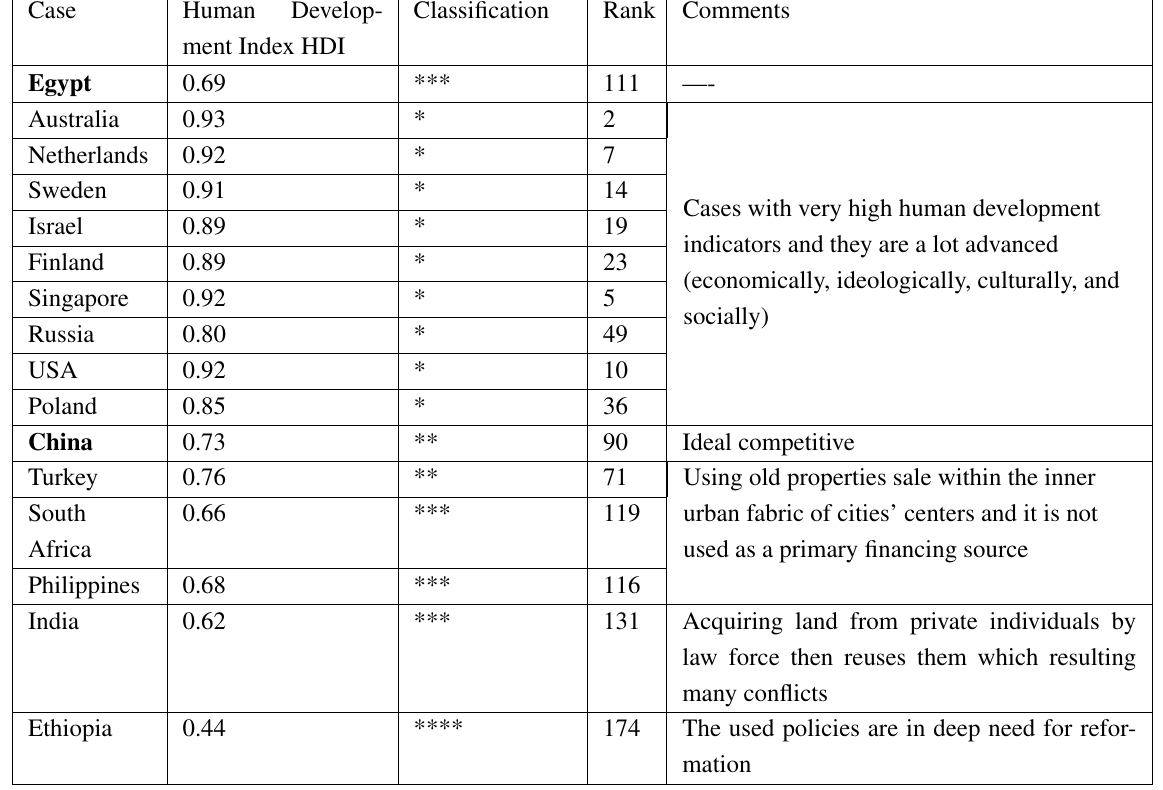
Table 3. Countries where governments use public lands as an asset for urban infrastructure financing